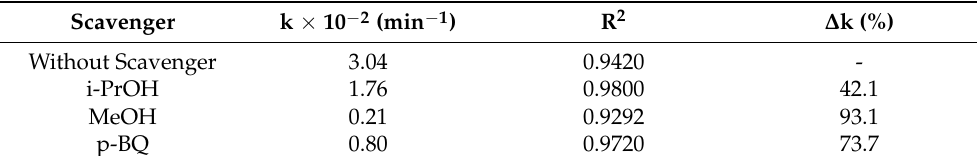
(% ∆ k) of amisulpride photocatalytic degradation in the presence of scavengers.